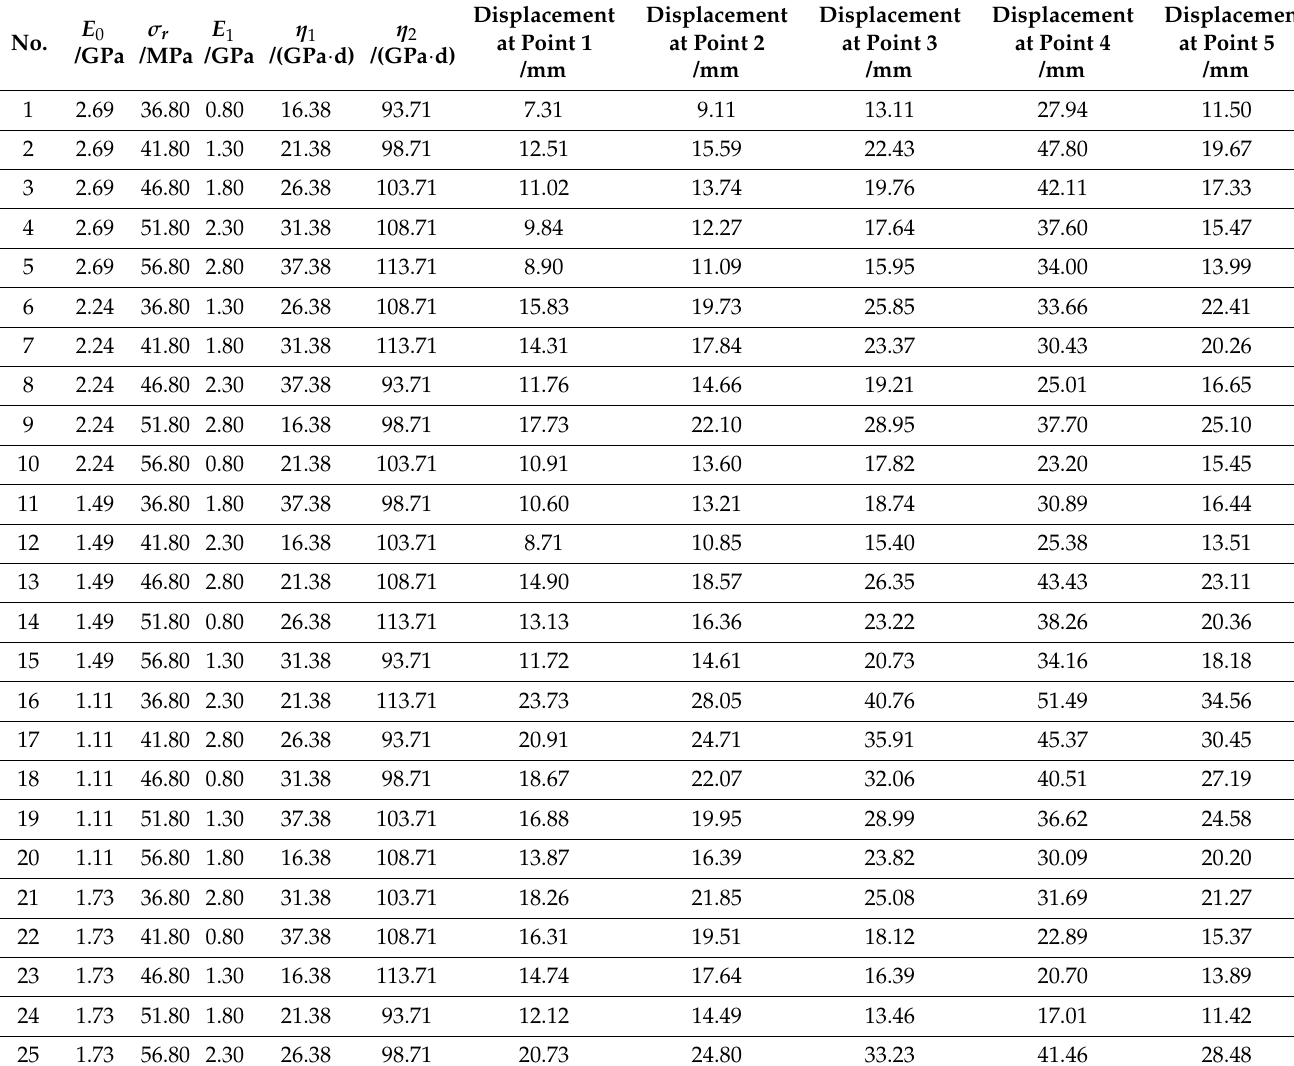
Table 8. The orthogonal test design plan and calculation results for Point